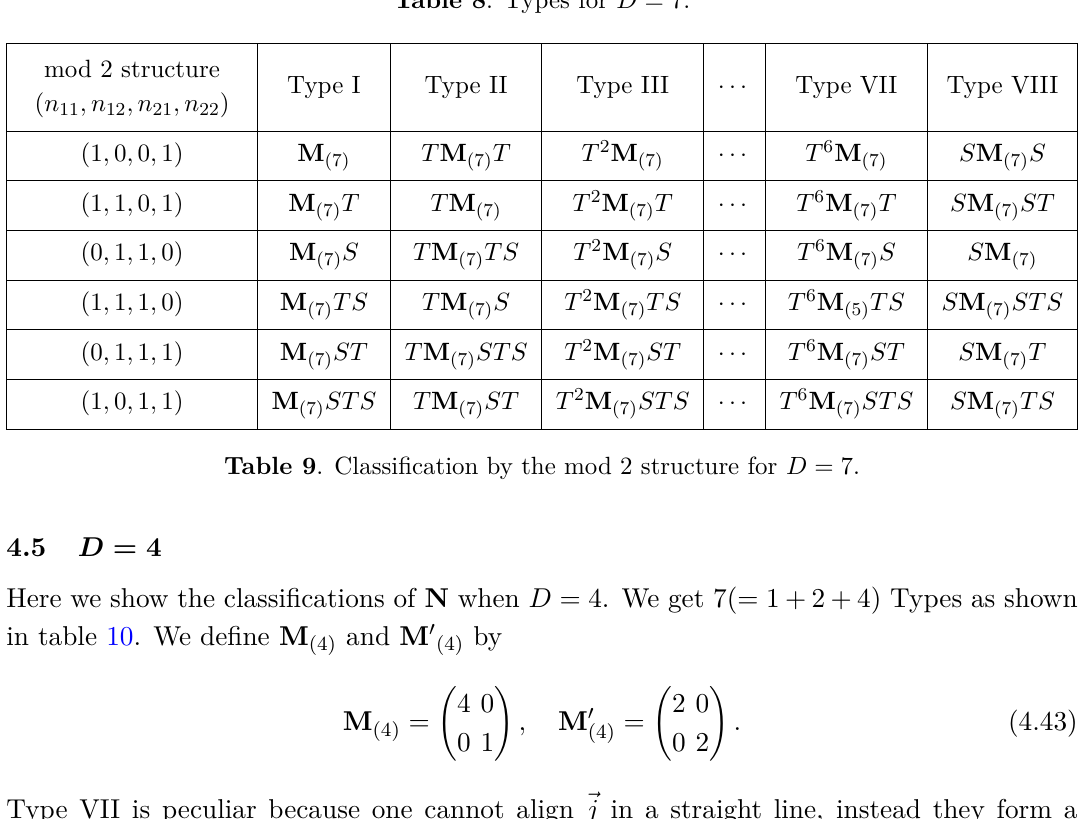
Table 8 . Types for D = 7 .